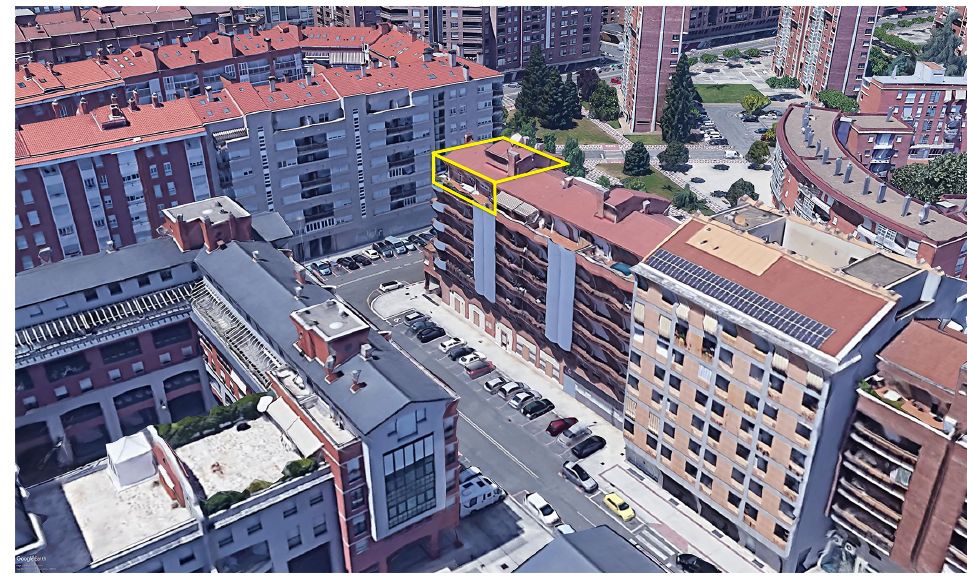
Figure 1. External view of the apartment is indicated in